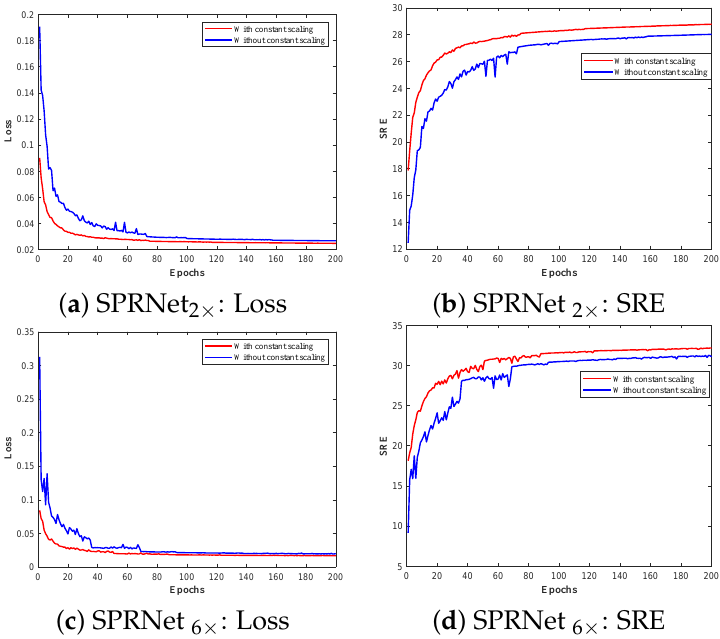
Figure 12. Training curves for SPRNet with and without constant scaling in ISFE. ( a ) The loss of SPRNet 2 ; ( b ) The SRE of SPRNet 2 ×